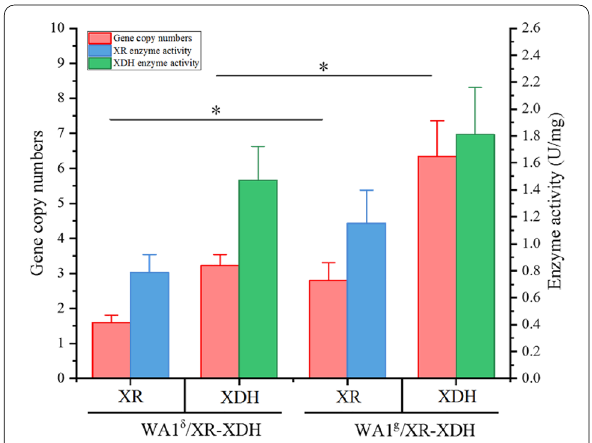
Fig. 1 Gene copy number and enzyme activity of the recombinant yeast strains with δ integration and Di-CRISPR, respectively. The values and error bars represent average readings and standard deviations for 3 qPCR reactions. *Indicates statistically significant differences between Di-CRISPR and conventional delta integration populations (student’s t test, p < 0.05)